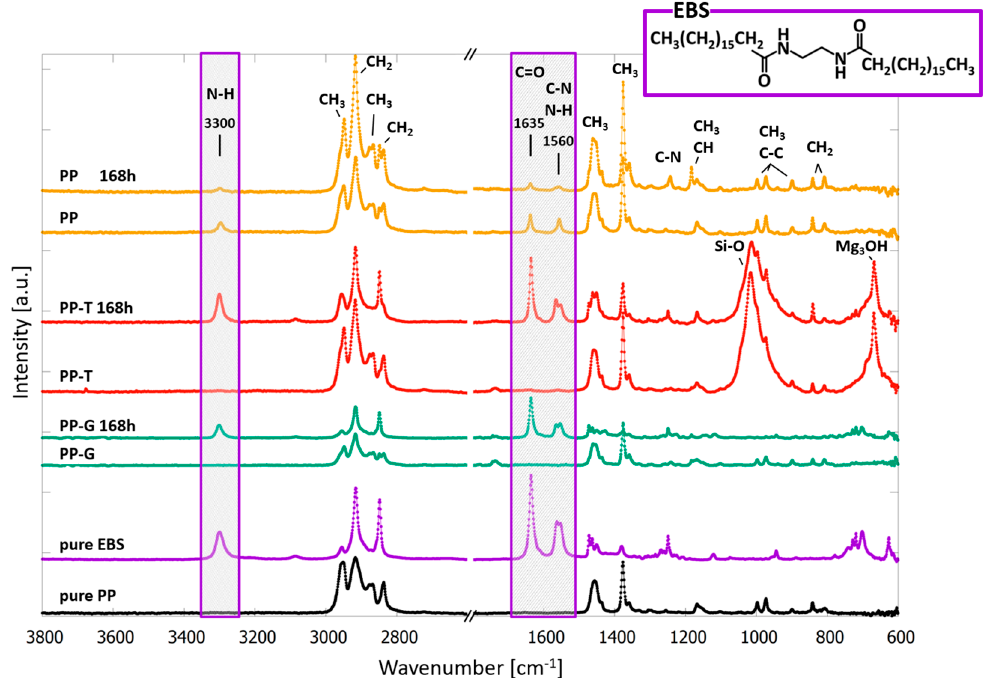
Figure 2. ATR-FTIR spectra of pure PP, pure EBS, PP-G after 0 h and 168 h, PP-T after 0 h and 168 h, and PP after 0 h and 168 h in the detergent at 95 °C. EBS bands 3300, 1635, and 1560 cm − 1 are highlighted. The EBS structural formula is presented in the upper right corner.